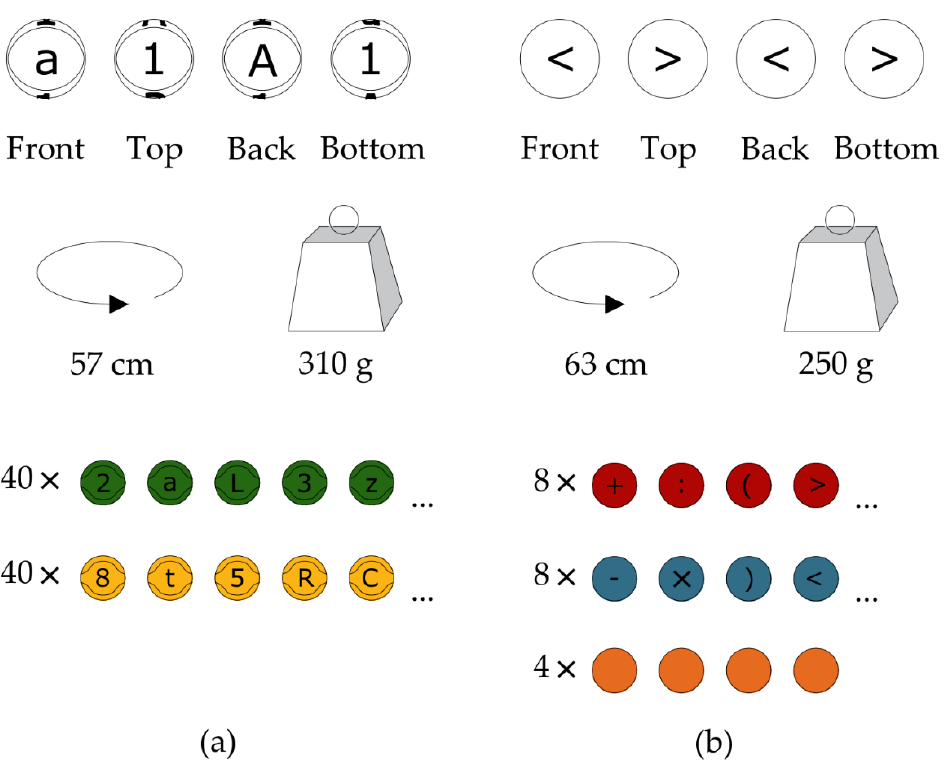
Figure 1. Eduball educational balls. ( a ) The first type of balls are in yellow and green colors (40 in each color) and are printed on one side with uppercase and the opposite side with lowercase black letters and numbers from 0 to 9. ( b ) The second type of balls are in red and blue colors (eight in each color), and mathematical symbols are painted on their surfaces; this set also contains unprinted orange balls.